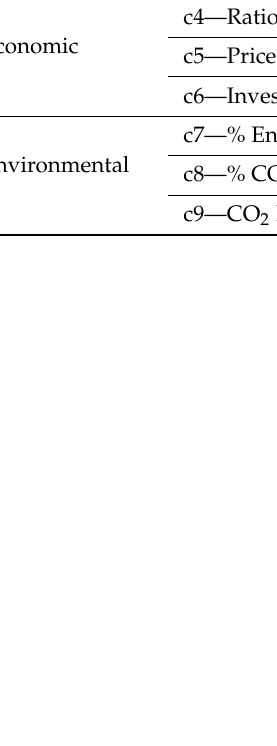
Table 2. Structural project failure